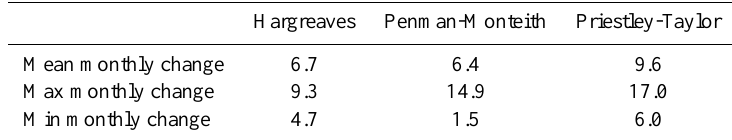
Table 2. Percent change in monthly PET from baseline to HadCM3 2 ◦ C scenario.